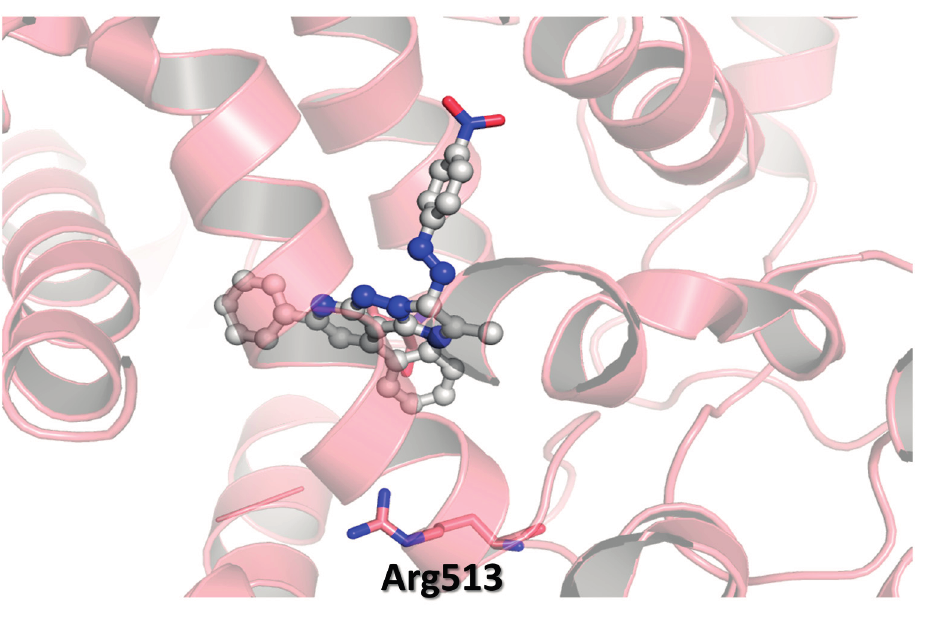
Figure 4. Hypothetical binding modes of compound 5i in COX-2 protein (PDB